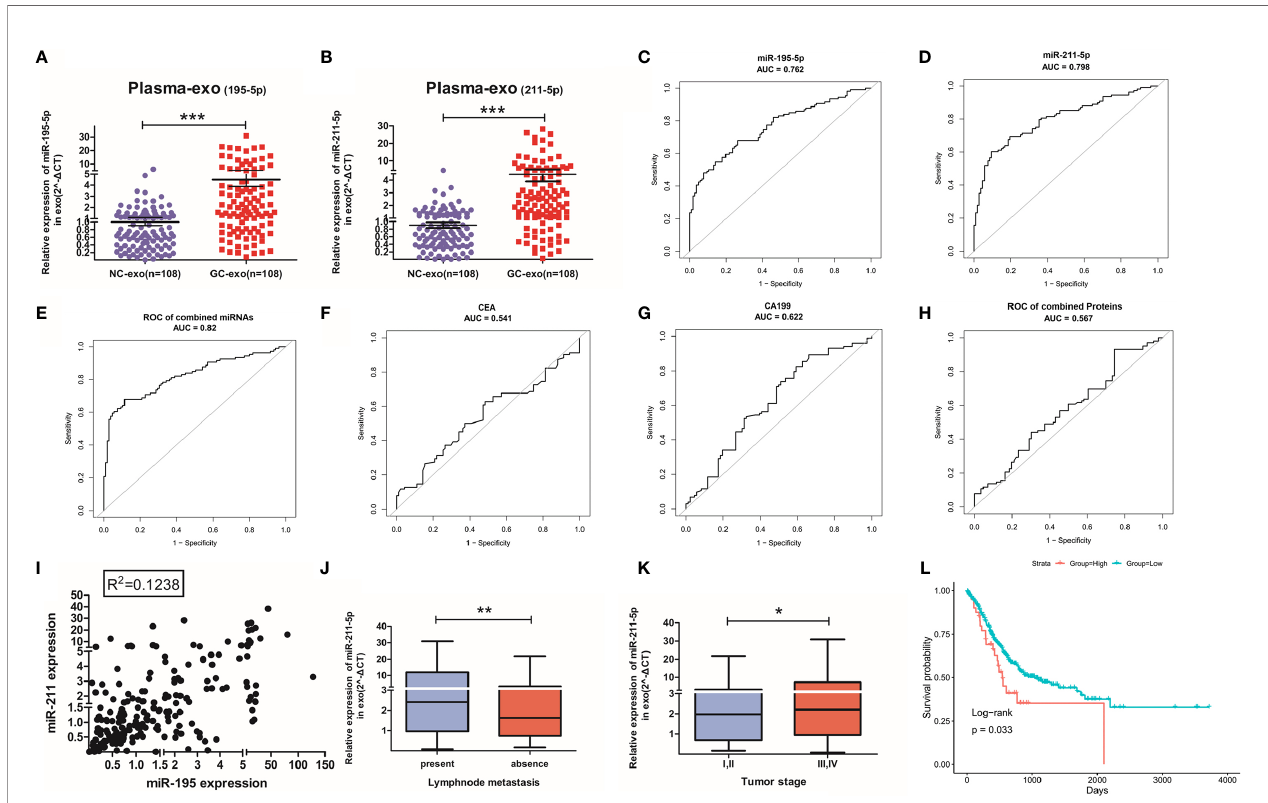
FIGURE 3 | Validation of miR-195-5p or miR-211-5p and their diagnostic accuracy. (A, B) . Large-scale analysis(n=88) of plasma exosomal miR-195-5p and miR- 211-5p levels were assessed with qRT-PCR. (C – E) . ROC curve of miR-195-5p, miR-211-5p and their combination in the validation population. (F – H) . ROC curve of CEA, CA19-19 and their combination in validation population. (I) . Scatter plot of the linear distribution of miR-195-5p and miR-211-5p expression in all samples during both phases of training and validation. (J, K) . Expression of exosomes miR-211-5p in lymph node metastasis circumstances and different tumor stages (*p-value<0.05, **p-value<0.01, ***p-value<0.001). (L) . OS and survival curves of miR-211-5p expression in gastric cancer in TCGA. (Top-10percentage: indicates that the 10% patients with the highest expression are compared with the 75% low expression